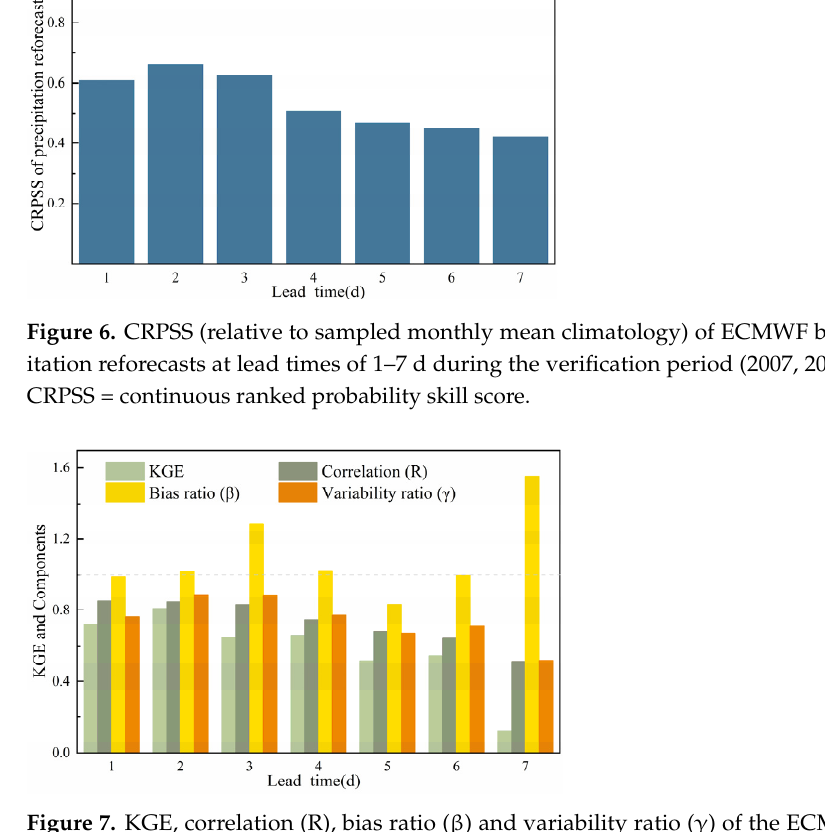
Figure 7. KGE, correlation (R), bias ratio ( β ) and variability ratio ( γ ) of the ECMWF precipitation reforecast ensemble mean over the verification period (2007, 2008, June–October). KGE = modified Kling–Gupta efficiency coefficient.